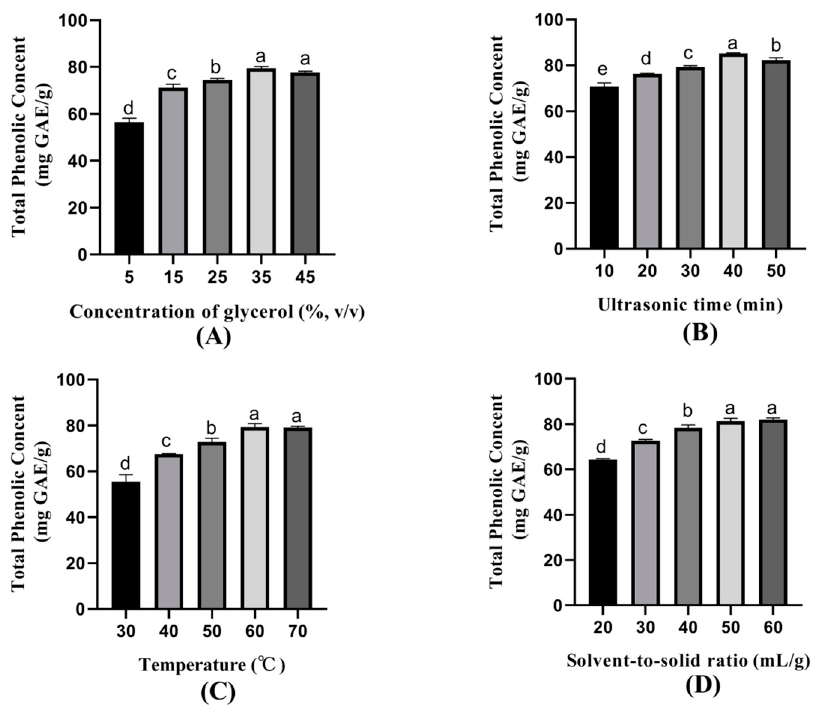
Figure 1. Effect of ( A ) concentration of glycerol, ( B ) ultrasonic time, ( C ) temperature, ( D ) solvent-to-solid ratio on total phenolic content. Data are reported as mean ± SD ( n = 3). Different letters, such as a, b, c, d, and e, showed significant difference ( p < 0.05).